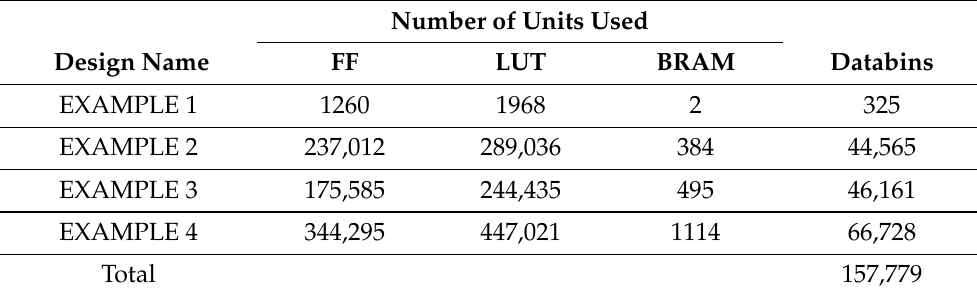
Table 2. Statistics of the training data. The examples E1–E4 are from the ISPD 2016 placement contest